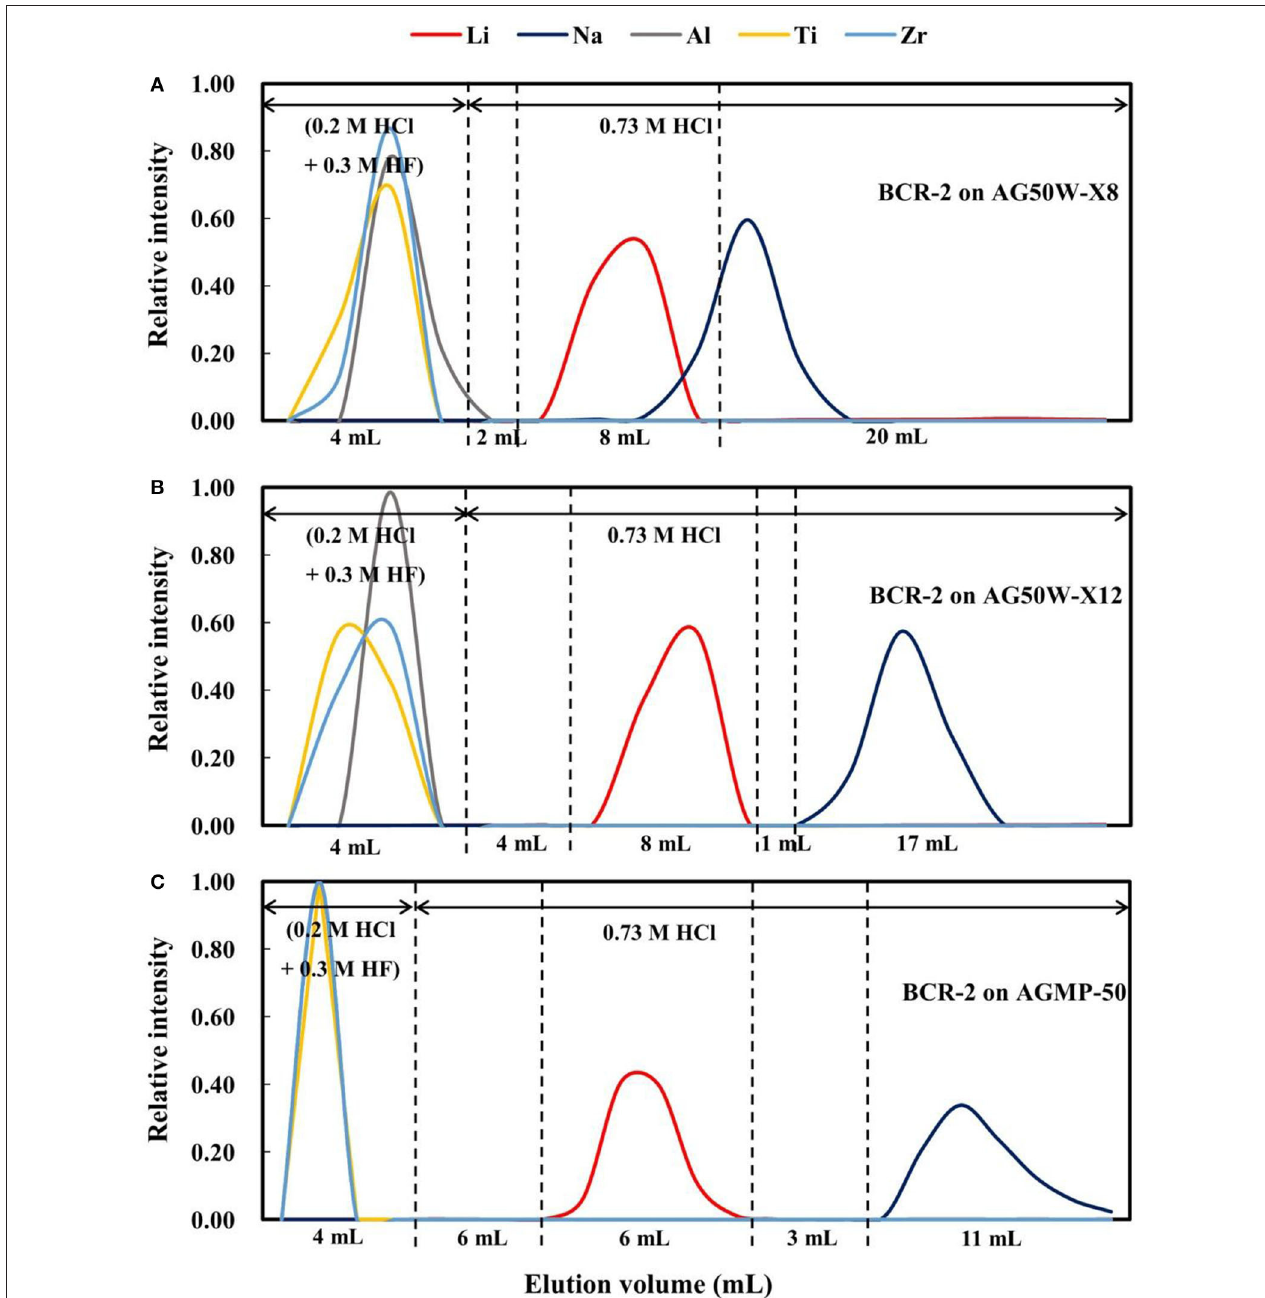
FIGURE 4 | (A) The elution curves for BCR-2 on AG50W-X8 resin; (B) The elution curves for BCR-2 on AG50W-X12 resin; (C) The elution curves for BCR-2 on AGMP-50 resin. Measurement introduced through a PFA nebulizer (50 µ L/min; ESI) and a quartz cyclonic–Scott dual spray chamber. An X skimmer cone was used instead of a H skimmer cone, to improve the instrument sensitivity. The total Li isotope intensity for a 100 ng g − 1 standard solution of NIST L-SVEC is 1.75 V on mass 7 Li. Details of ∼ the typical MC-ICP-MS operating parameters are summarized in Table 3 .